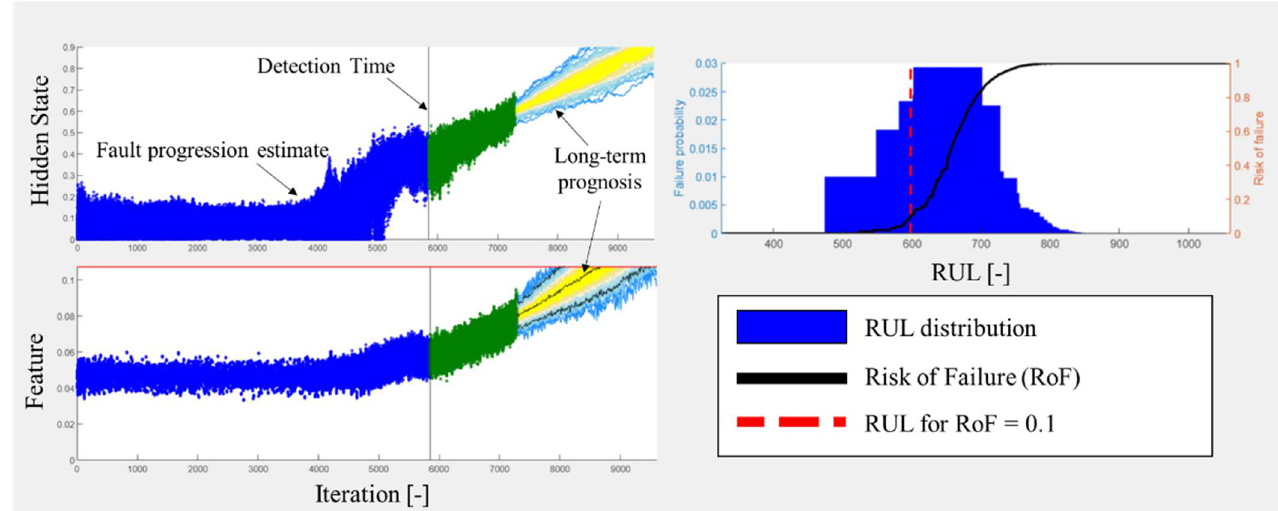
Figure 18. Example of the particle filter framework output.